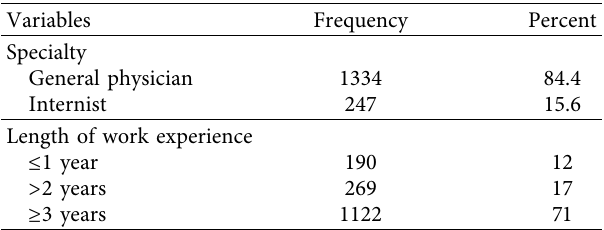
Table 3: Physicians’ characteristics for medications prescribed in patients with renal impairment admitted to medical wards at Amhara region referral hospitals, Amhara Ethiopia, in 2020 ( n �